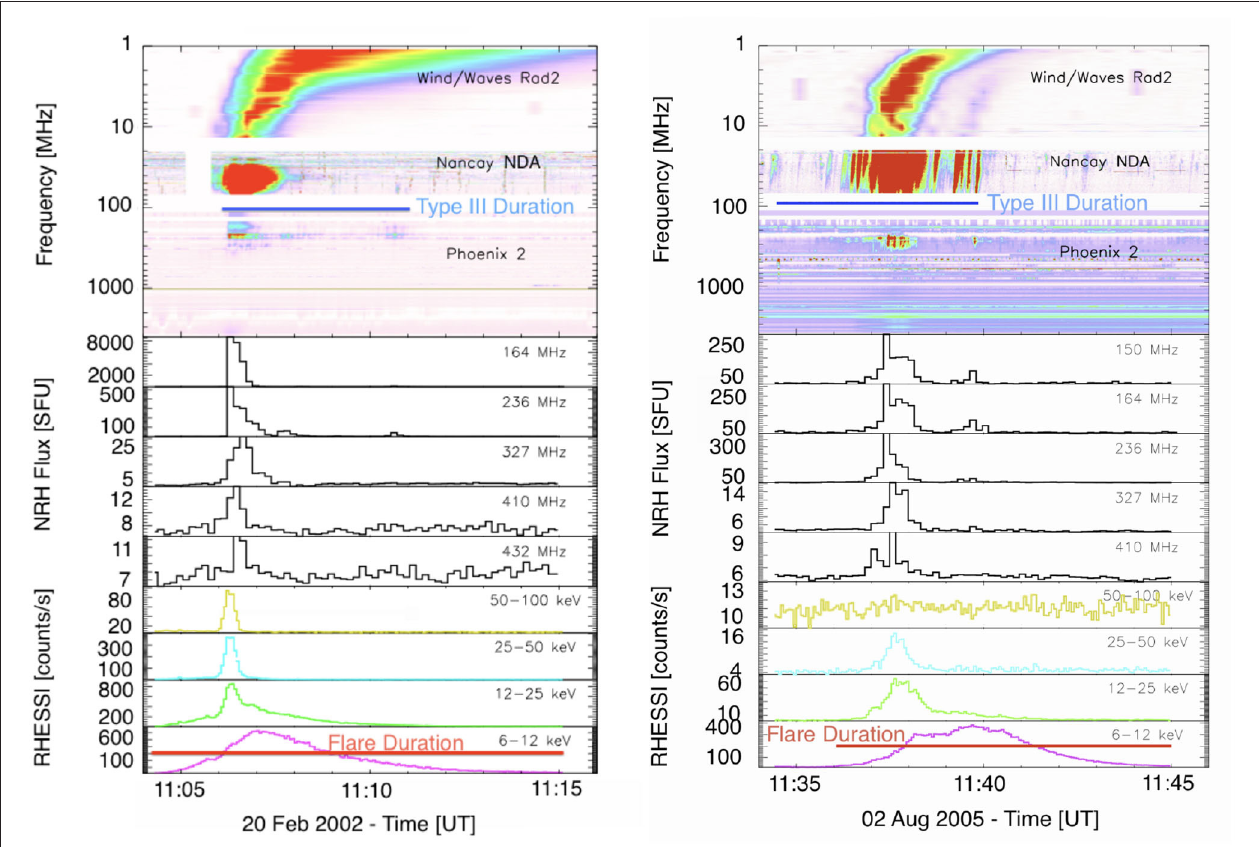
FIGURE 3 | An example of two type III bursts with associated X-ray flares, highlighting the temporal correlation between hard X-rays and type III radio emission. The flare and radio burst durations are indicated, with the longer flare duration defined both by accelerated electrons and cooling bulk plasma. From Reid and Vilmer